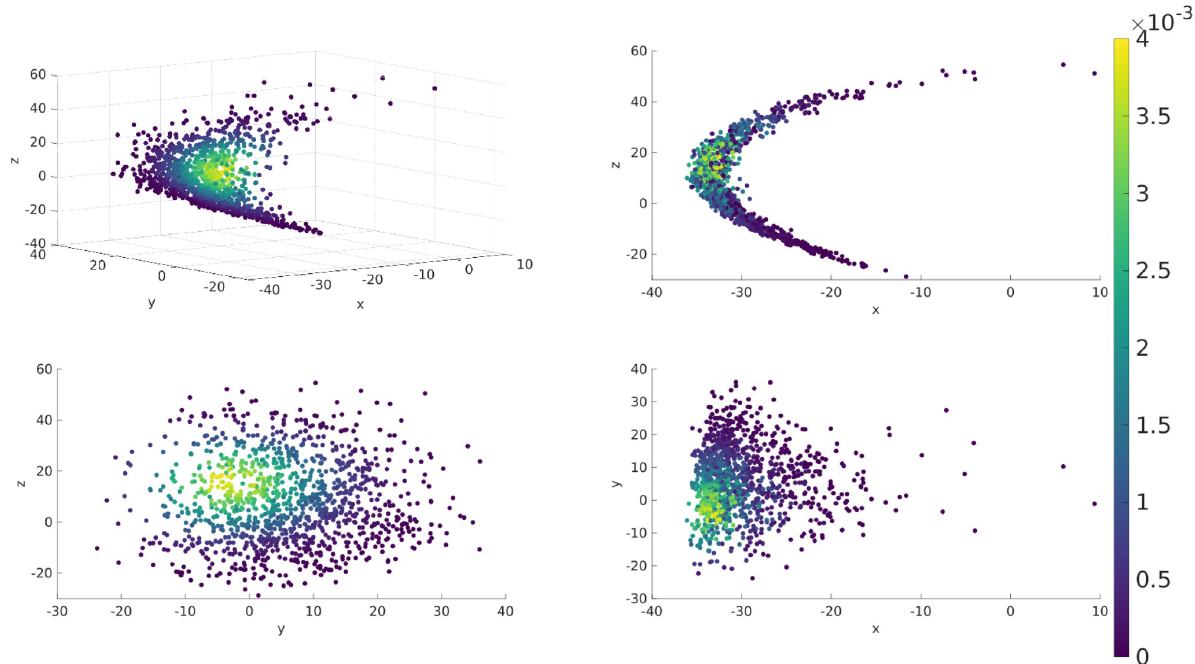
Fig 4. After one ensemble forecast (ensemble size is 1200) the deviations from the forecast mean are projected into the three leading eigenvectors of the empirical covariance matrix, with projection coefficients denoted x , y , and z . The four panels show four different perspectives on the projected ensemble. The color of each dot corresponds to the particle filter weight assigned using a split α chosen to yield an effective sample size of ESS = 600.